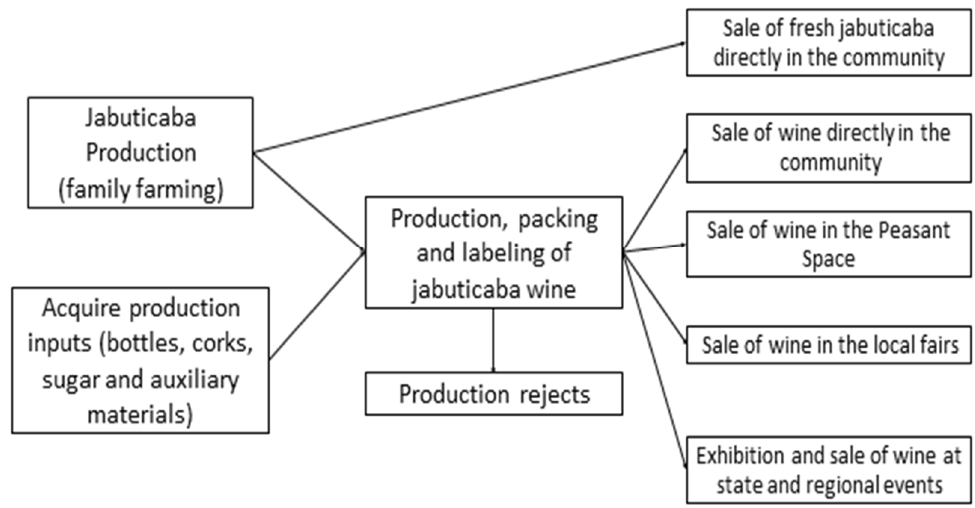
Figure 1. Jabuticaba supply chain in Palmeira dos Índios.